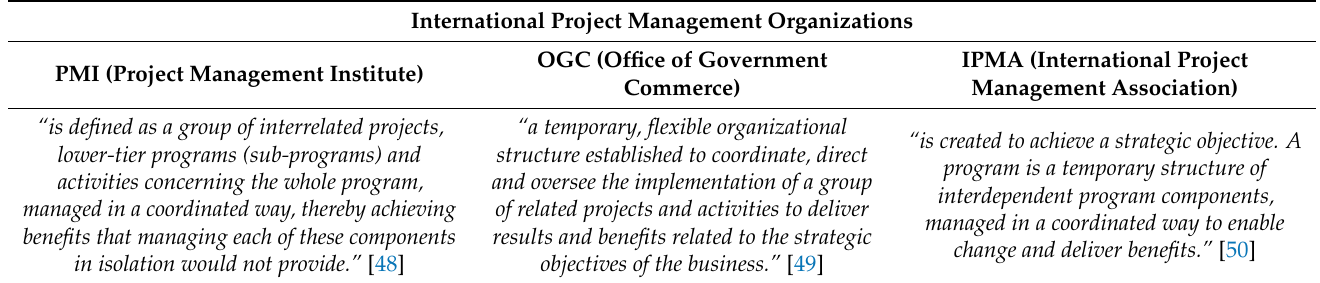
Table 1. Program definition according to international